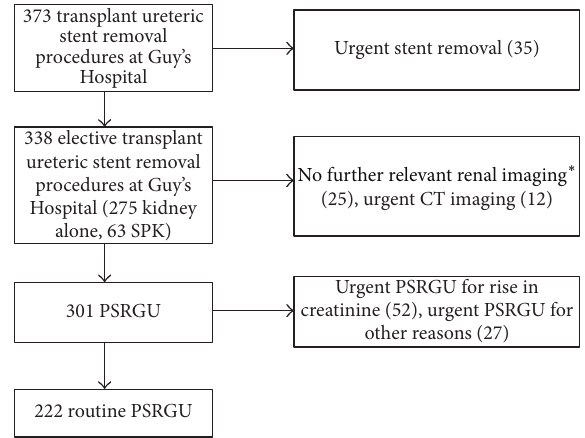
Figure 1: Flow chart summarising recipients of single kidney trans- plants undergoing stent removal at Guy’s Hospital. ∗ Seven patients were followed up in units where routine PSRGU are not